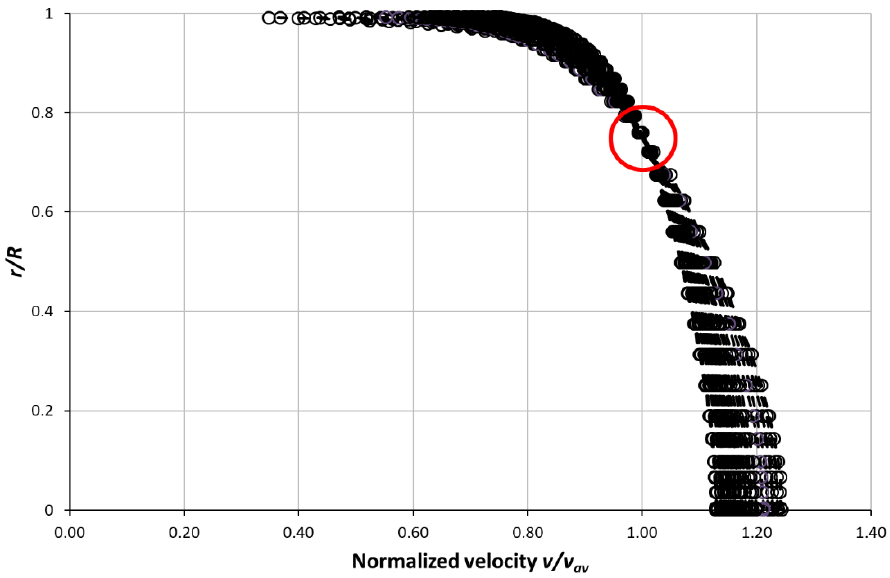
Figure 9. All mean velocity profiles measured by Zagarola [3] on PSP. There are 26 profiles for the Reynold’s number range <31,577, 35,259,000>.